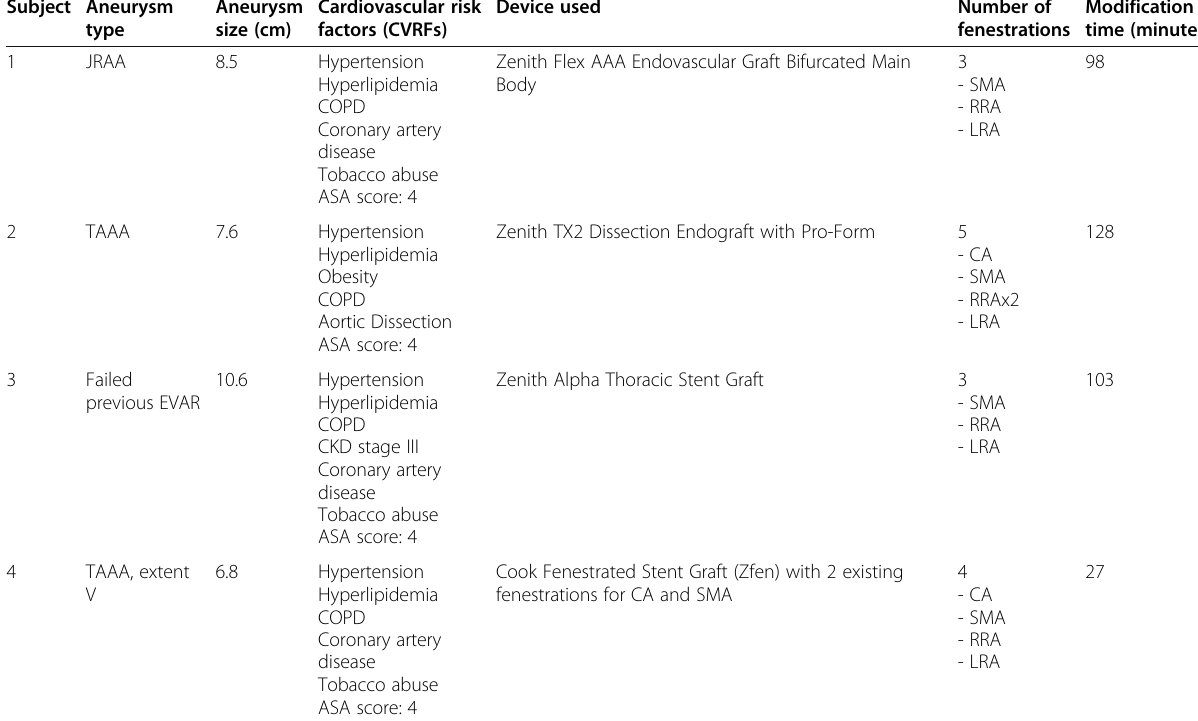
Table 1 Aneurysm type, Risk factors and Modification